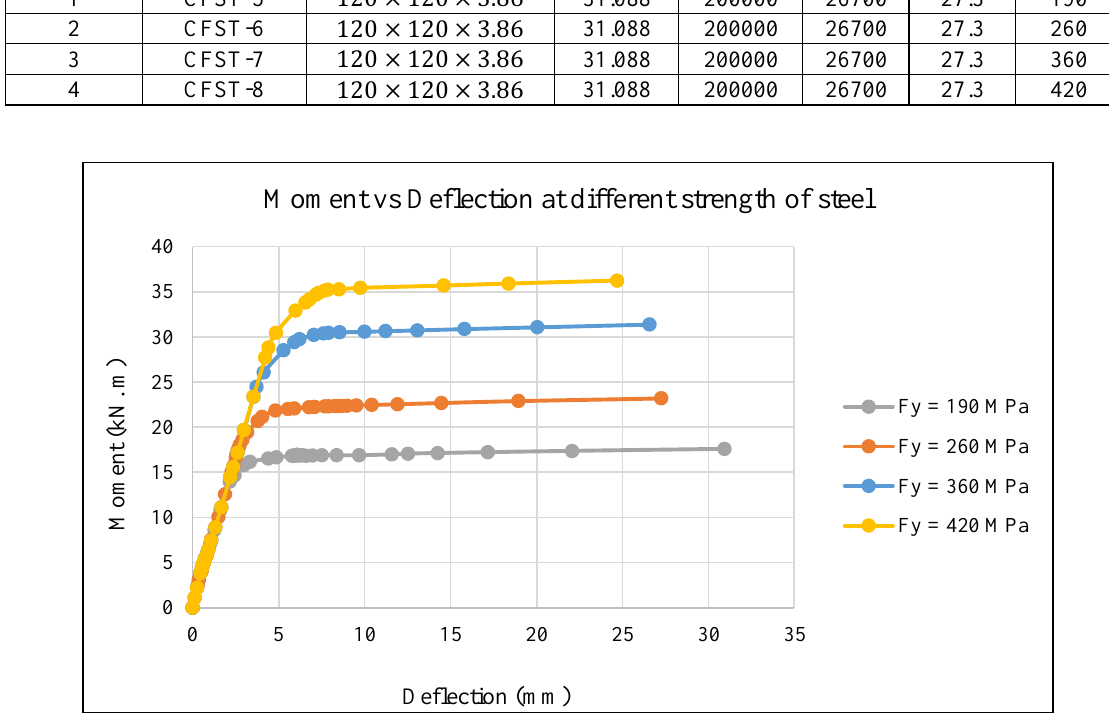
Fig. 10. Moment vs deflection for different yield strength of